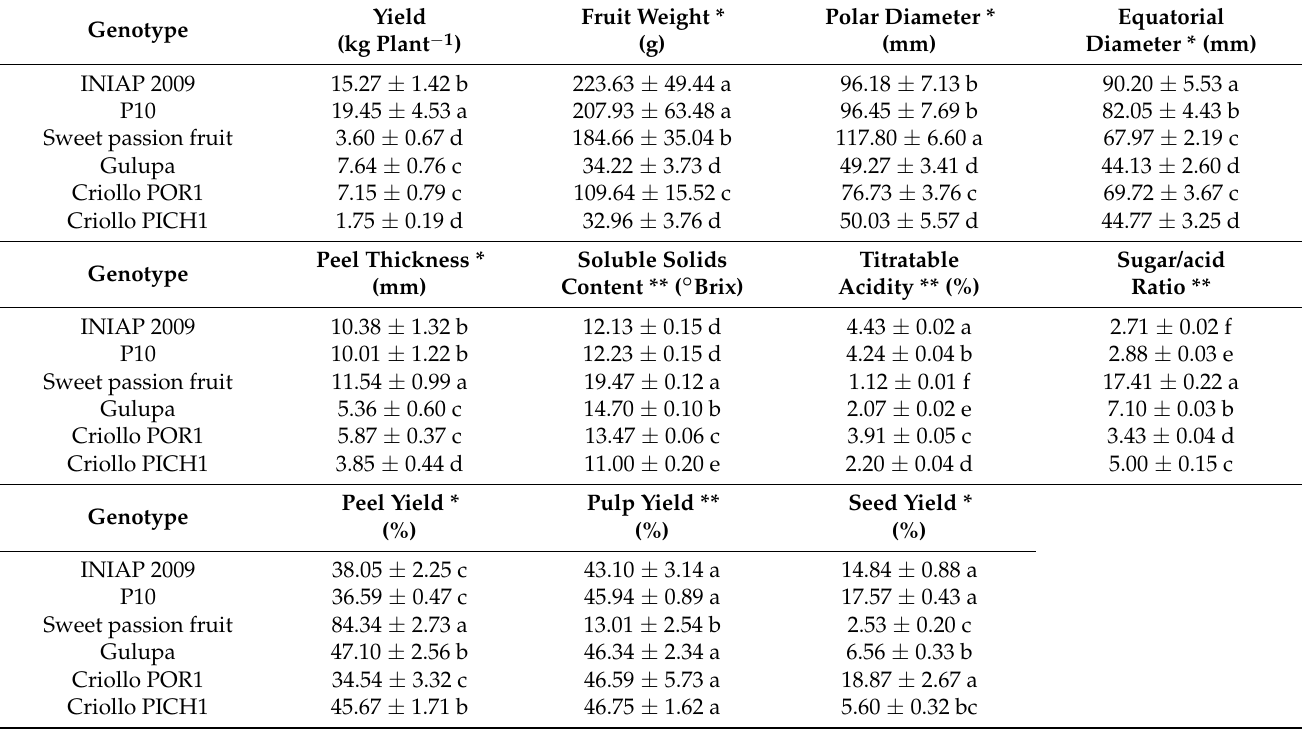
Table 1. Fruit quality parameters of the passion fruit germplasm grown in